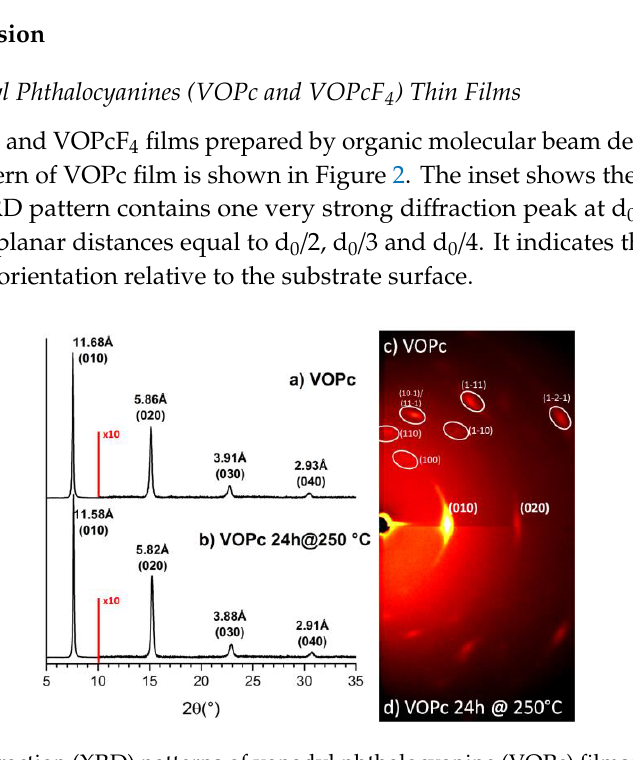
Figure 2. X-ray diffraction (XRD) patterns of vanadyl phthalocyanine (VOPc) films: as-deposited ( a ), after annealing for 24 hours at 250 °C ( b ). The range from 10° to 35° 2θ is shown with 10-fold magnification. Two-dimensional grazing incidence X-ray diffraction (2D GIXD) patterns of the films before ( c ) and after annealing ( d ).